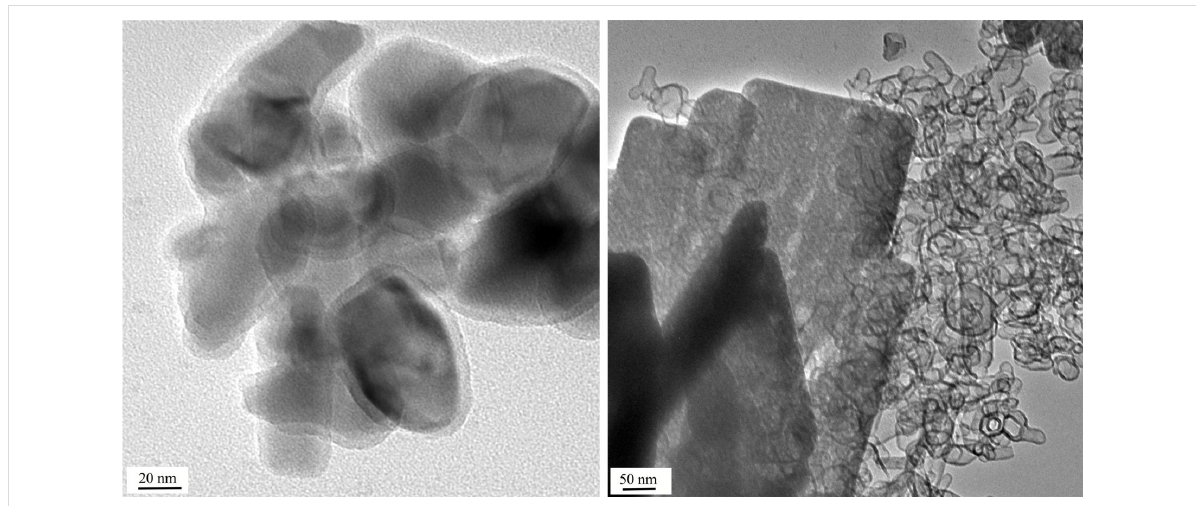
Figure 5: SiO 2 -coated labelled ZnO-NP (sample 4 ; shell thickness 3–6 nm) before (left; scale bar 20 nm) and after (right; scale bar 50 nm) 24 h de- gradation reaction with buffer B.